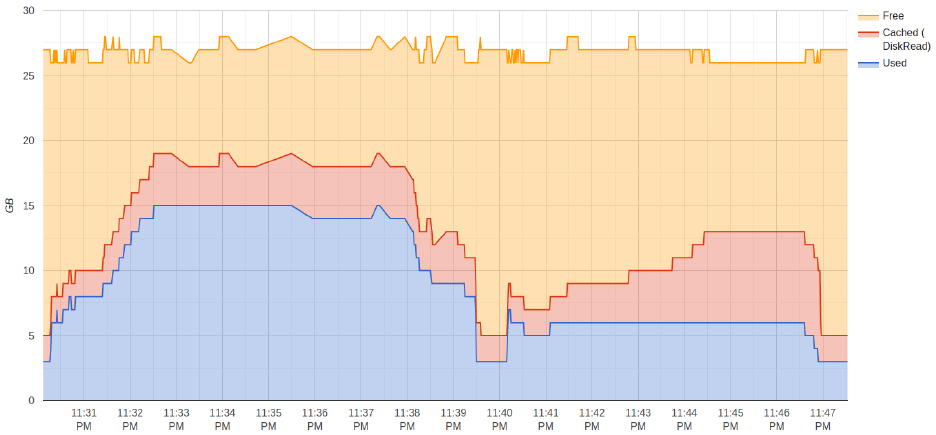
Figure 8. RAM usage of BitTorrent during a stress test, 100 nodes, 50 MB